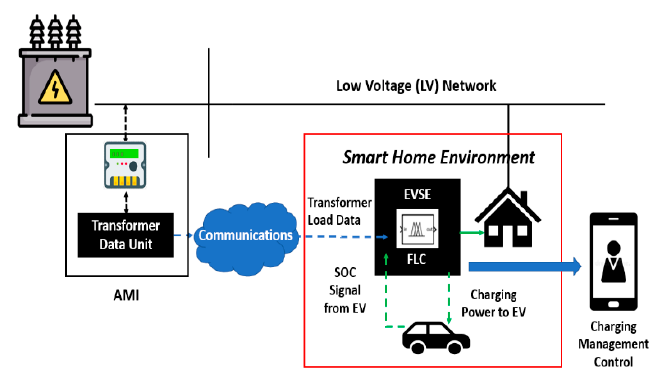
Figure 1. FLC-based smart charging.